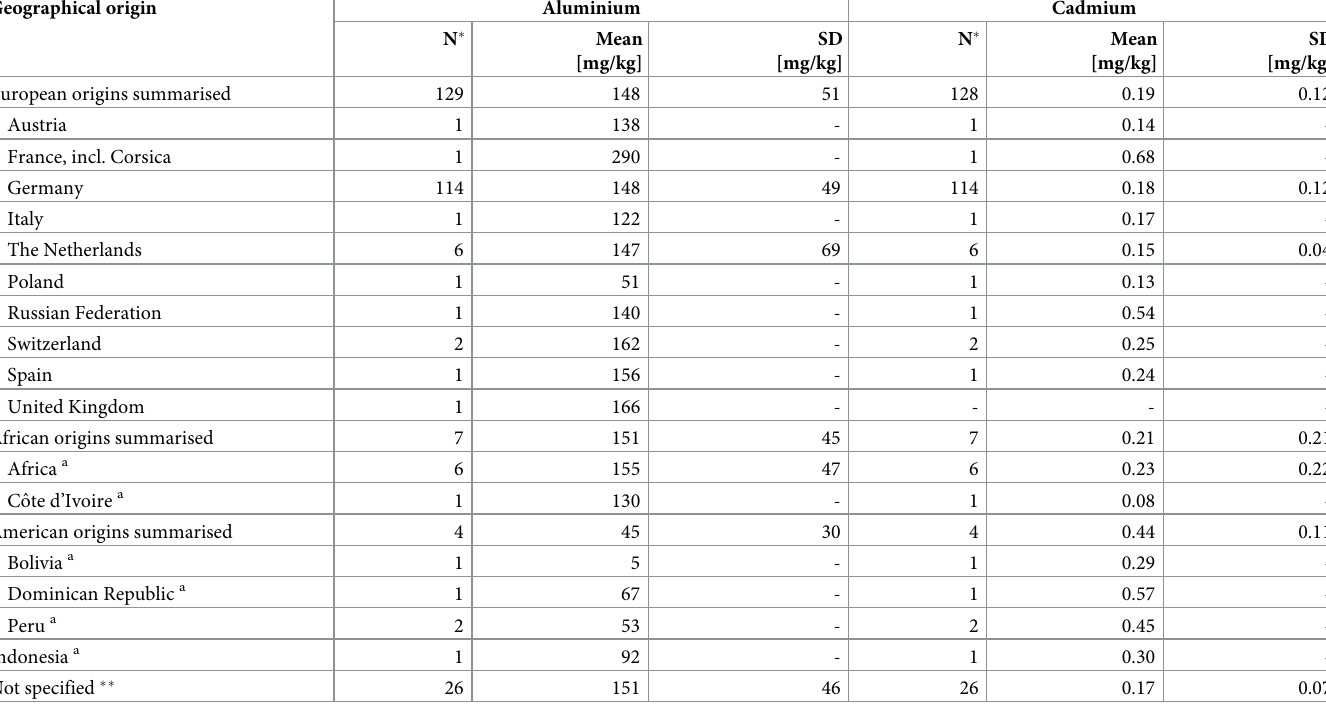
Table 2. Aluminium and cadmium concentrations in cocoa powder by geographical origin available in German Food Monitoring (GFM) 2005–2015. N sample number, SD standard deviation. All cocoa powder samples analysed for aluminium and cadmium had quantifiable concentrations. Methods used for analysis: